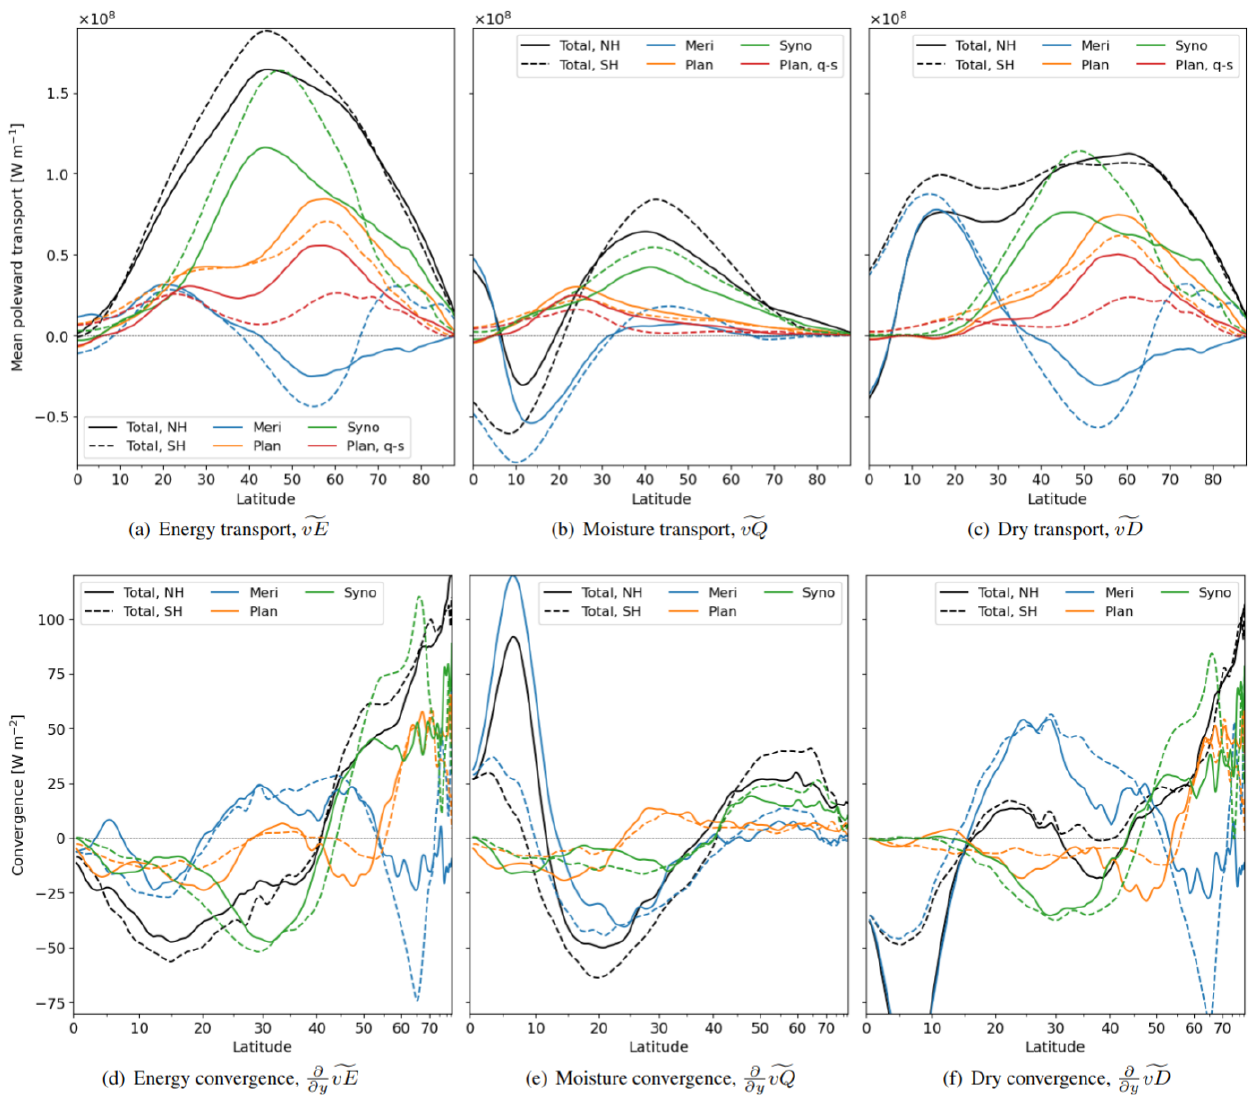
Figure 5. (a) Annual-mean, zonal-mean poleward atmospheric energy transport from ERA5. The transport of the Northern Hemisphere and Southern Hemisphere are depicted in solid and dashed lines, respectively. The total energy transport (black) is divided into the zonally symmetric meridional overturning circulation (blue) and wave components at the planetary (orange, waves ≥ 8000km) and synoptic scales (green, < 8000km). The quasi-stationary contribution of the planetary transport on a monthly scale is depicted in red. (b, c) As panel (a) but for the latent and dry energy transport components, respectively. (d–f) Resulting convergence of atmospheric energy from the transport components presented in panels (a) – (c) but for simplicity omitting the convergence of quasi-stationary planetary transport. The latitudes on the x axis are scaled to represent equal surface areas such that the integrated convergence in each component becomes